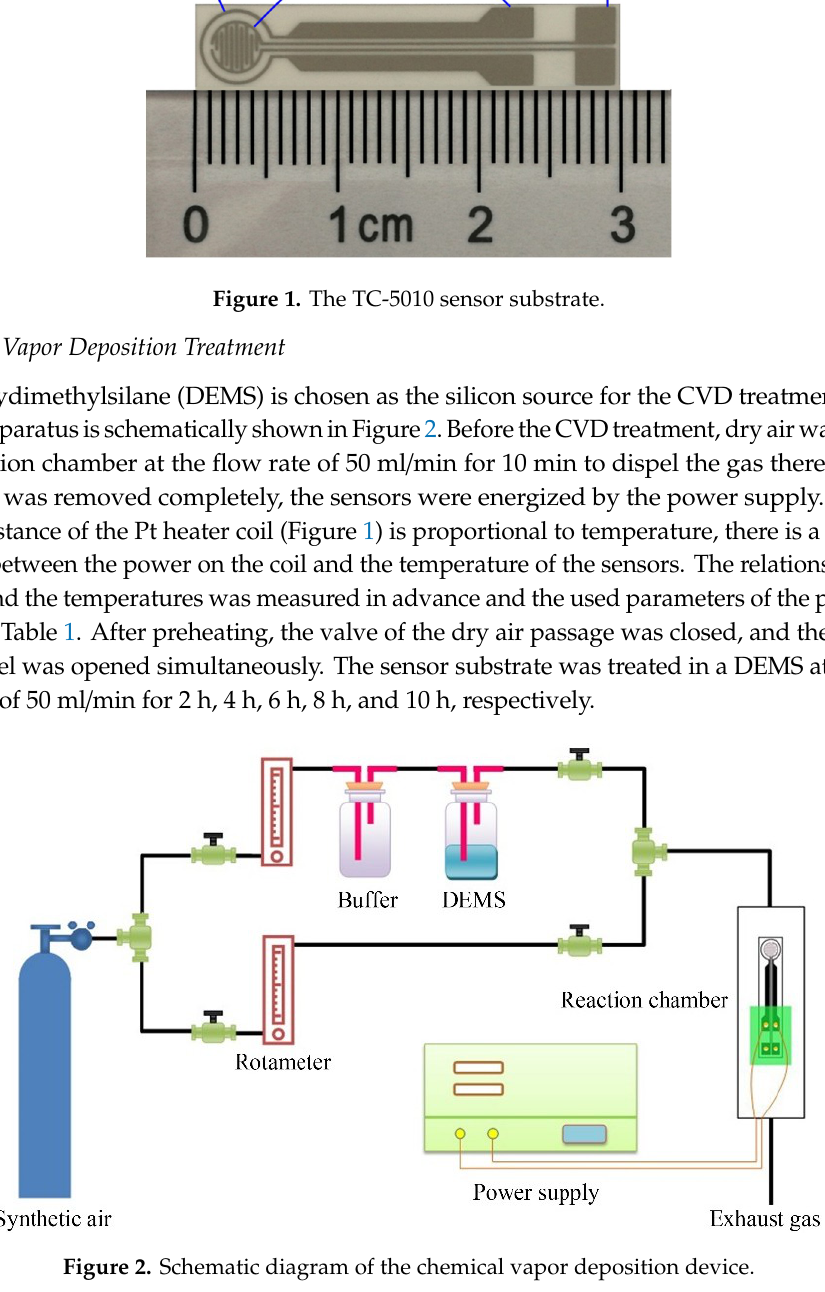
Figure 1. The TC-5010 sensor substrate.